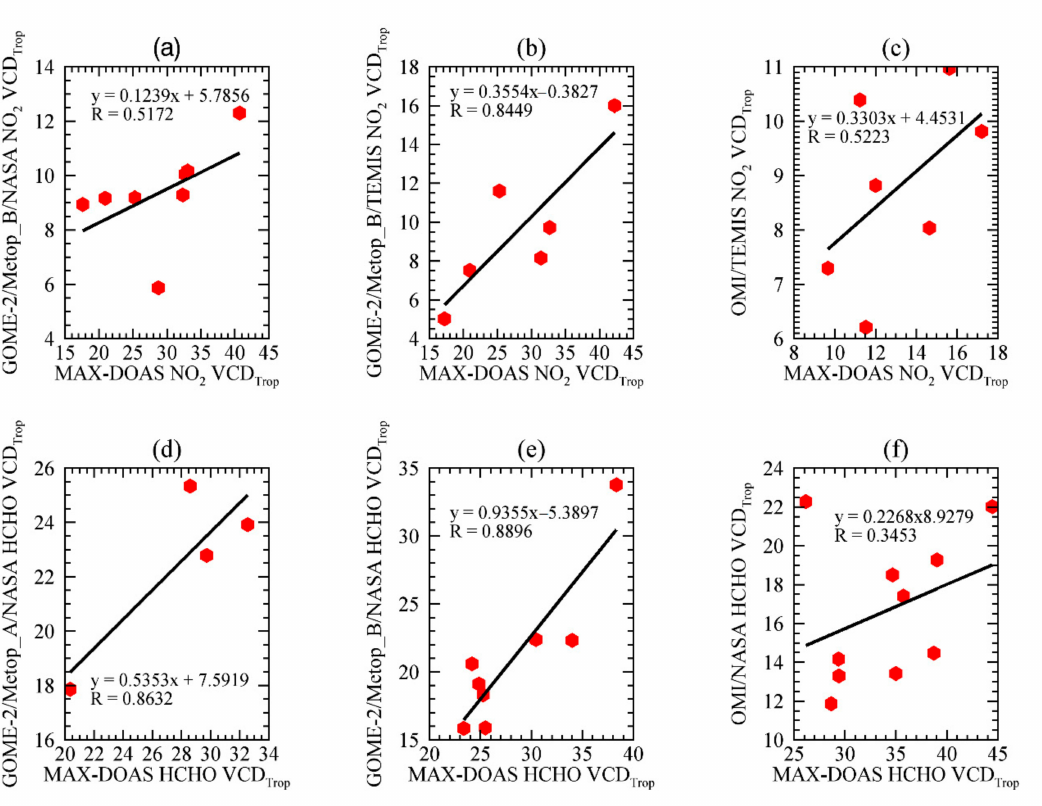
Figure 11. Correlation analysis of NO 2 tropospheric VCD satellite products from ( a ) GOME-2/MetOp- B/NASA; ( b ) GOME-2/MetOp-B/TEMIS; ( c ) OMI/TEMIS and retrieved results, Correlation analysis of HCHO tropospheric VCD satellite products from ( d ) GOME-2/MetOp-A/NASA; ( e ) GOME- 2/MetOp-B/NASA; ( f ) OMIL2/NASA and retrieved results (unit: 10 15 molec · cm − 2